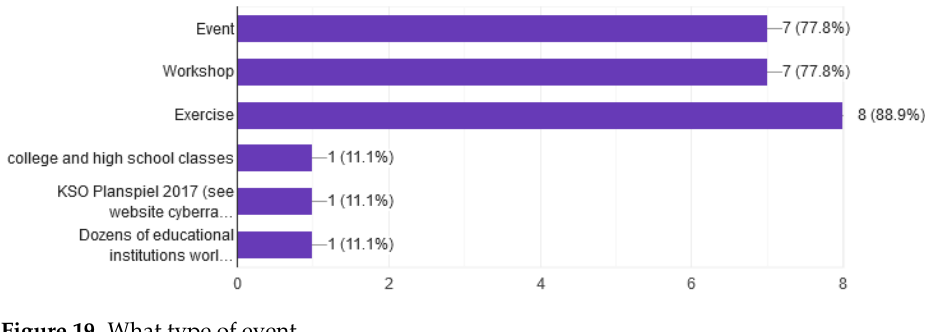
Figure 19. What type of event.